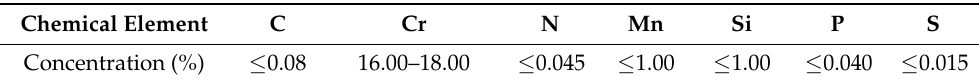
Table 1. Chemical composition of AISI 430 stainless steel, provided by manufacturer (Acerinox, Madrid,